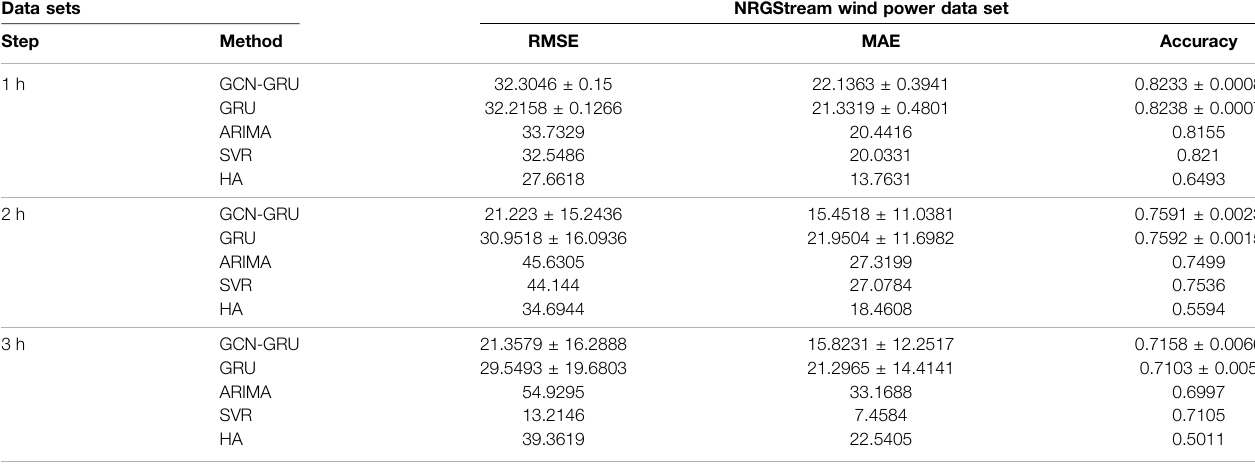
TABLE 3 | NRGStream wind power experiments.